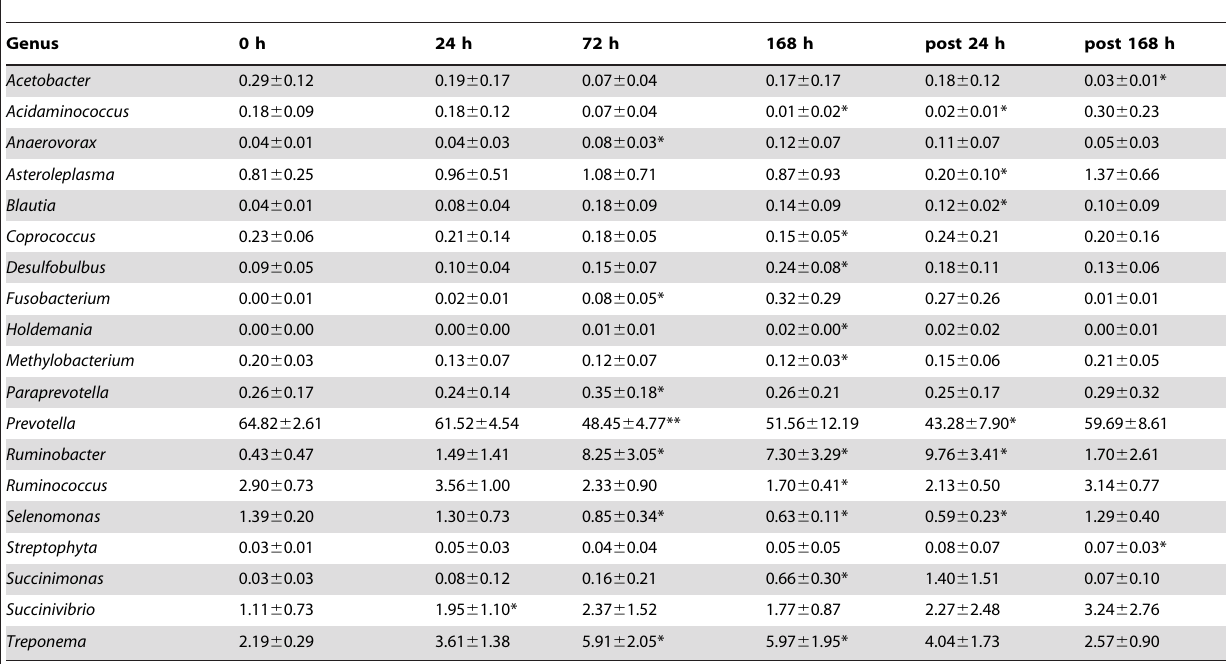
Table 2. Ruminal butyrate infusion resulted in a profound change in genus-level microbial composition (mean percentage 6 SD; N